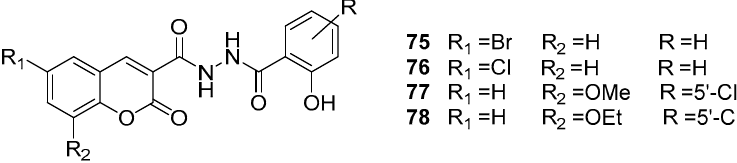
Figure 29. Coumarin derivatives synthesized by Jesumoroti and co-workers [117].